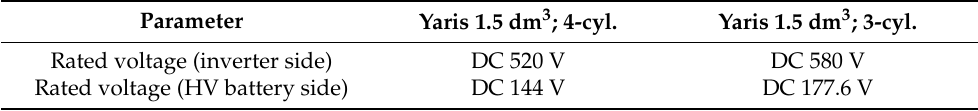
Table 3. Characteristics of the boost converters